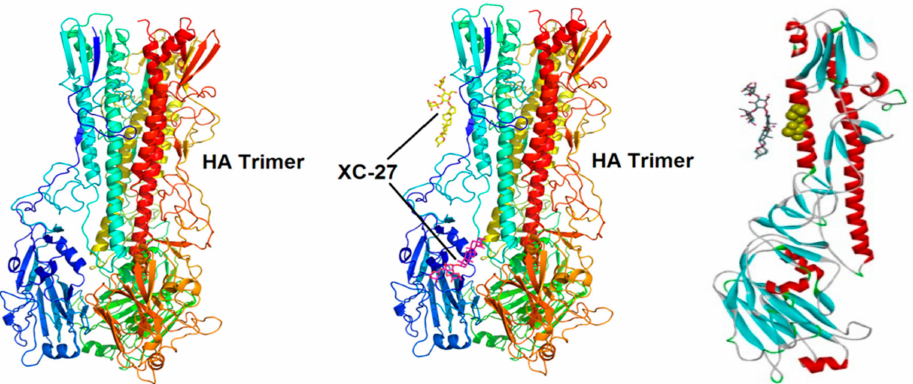
Figure 8. Computational structural prediction for potential binding sites between the derivative XC-27 and HA protein. Using the hemagglutinin crystal structure (2IBX) of the virus VN1194 (H5N1) as a reference structure, all of the available HA sequences and highly homologous HA crystal structure were retrieved from NCBI and PDB databases respectively, based on this, accurate 3D space structures of HA were constructed by using Modeller 9.x software, the molecular docking between XC-27 and HA was performed using AutoDock